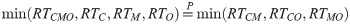
The observed distributions of RT
C, RT
M, RT
O, RT
CM, RT
CO, and RT
MO for an observer are used to predict the distribution of RT
CMO for the same observer (SA who was also in Figs 3 and 5) by the non-spurious race equality min(RTCMO,RTC,RTM,RTO)=Pmin(RTCM,RTCO,RTMO).The predicted and observed distributions of RT
CMO are statistically indistinguishable from each other (p = 0.094). This figure has the same format as Fig 3.